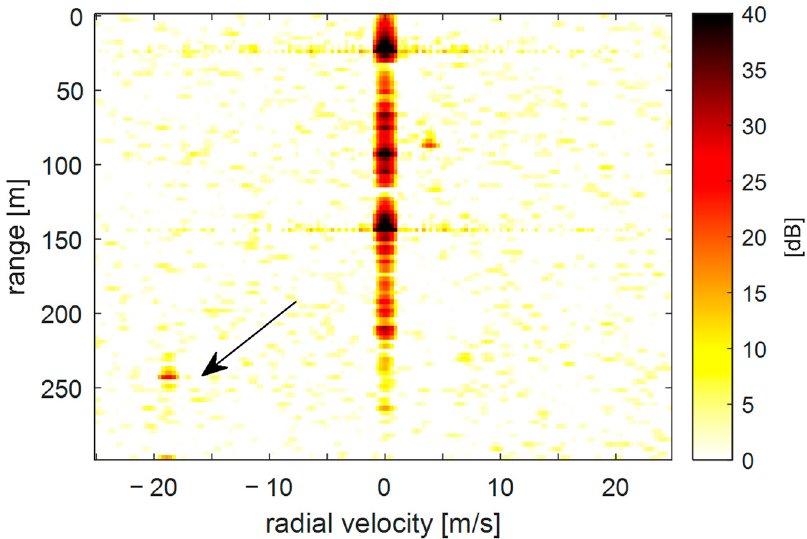
Figure 12. C rossambiguity function with marked repeater echo.